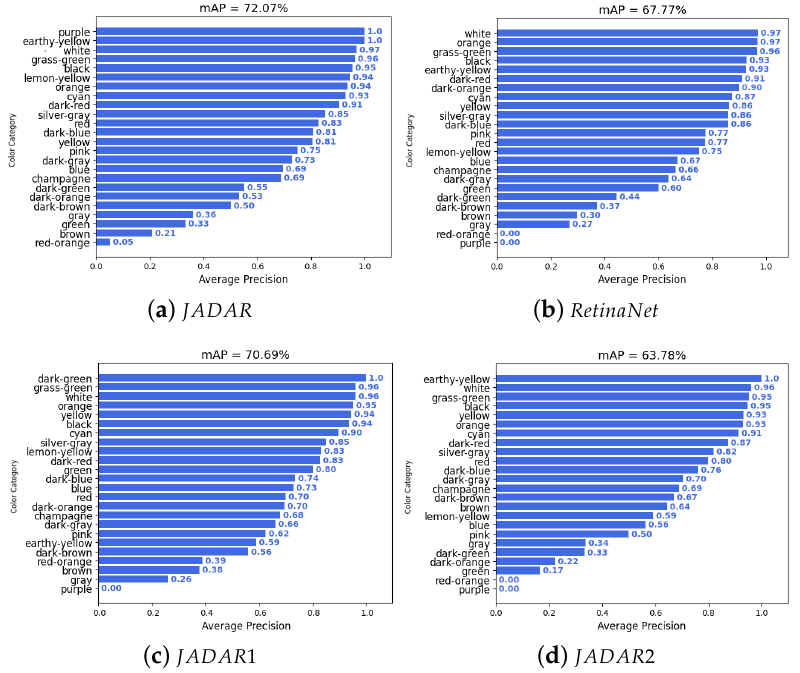
Figure 5. AP s of different models on the Rain Vehicle Color-24 test set. The x -axis represents the average precision, and the y -axis represents the color categories (24 categories in